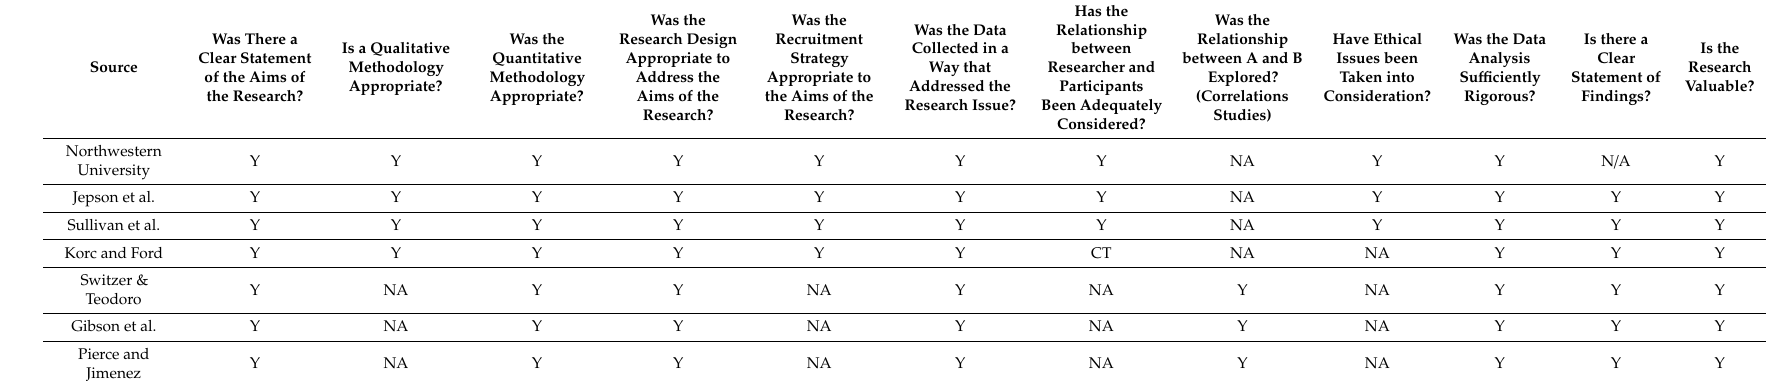
Table 2. Critical Appraisal of Descriptive and Correlational